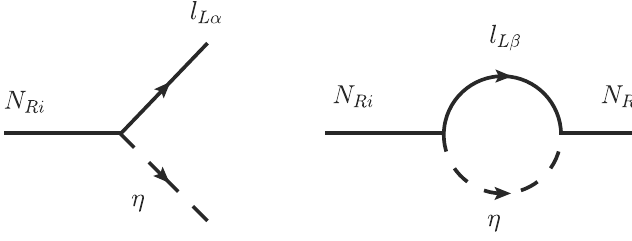
measures the total decay rate of N 1 with respect to the Hub- ble expansion rate, and similarly, W Total ≡ the total washout rate. Here, K N decay parameter. In the second term on right hand side of Eq. (7), we consider N 1 annihilations into all SM fermions mediated by Z BL along with N 1 annihilations to pair of Z BL as well as η . Similarly, n B − L in Eq. (8) denotes the comoving number density of B − L generated from CP violating out- of-equilibrium decay of N 1 . The CP asymmetry parameter on the right hand side of Eq. (8) is defined